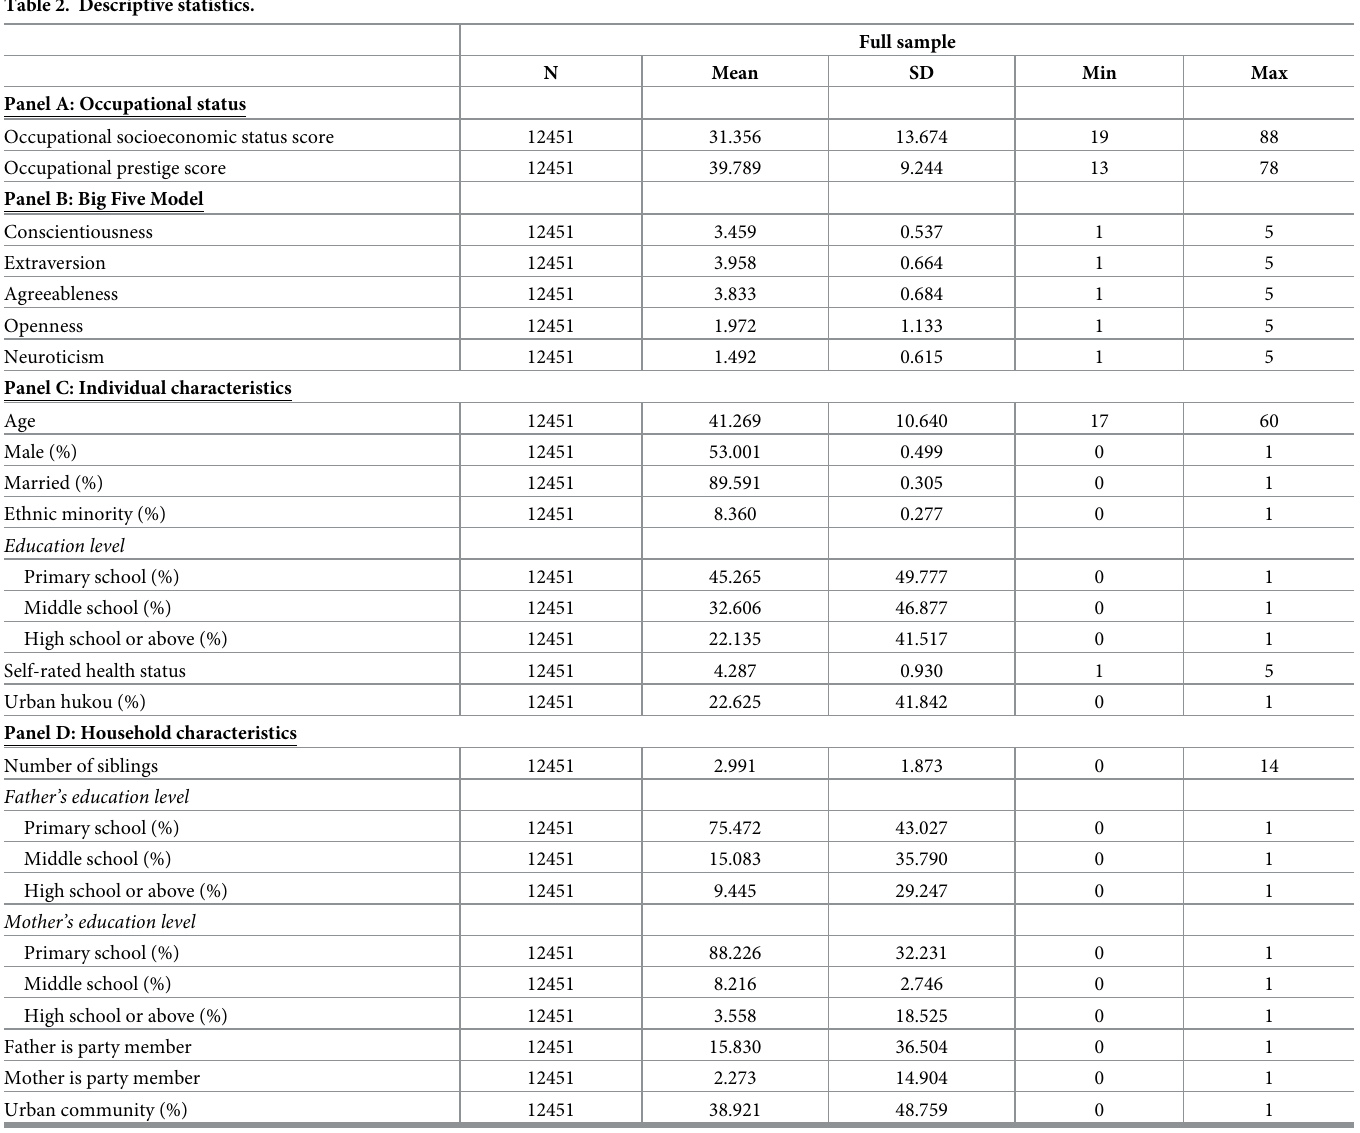
Table 2. Descriptive